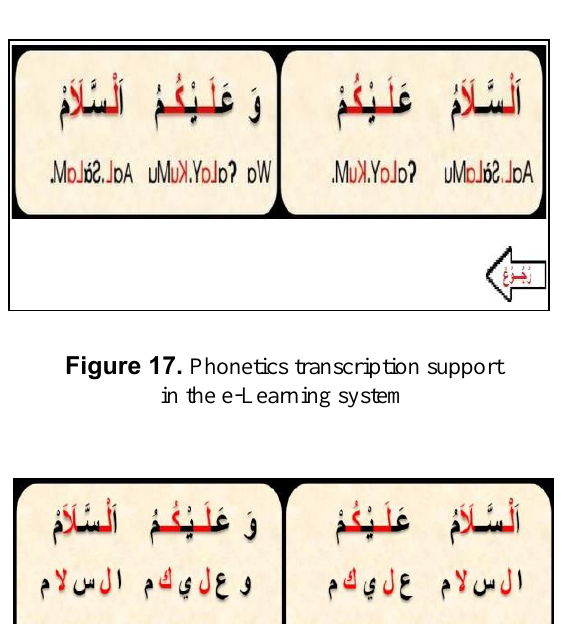
Figure 16. Identification of Arabic letters in the e-Learning system